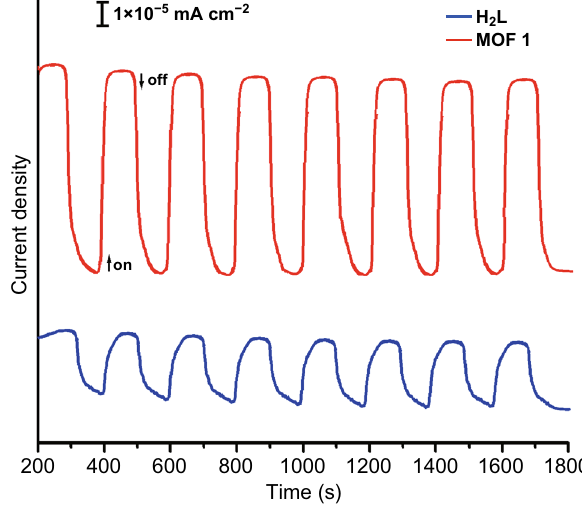
Fig. 3 Comparison of photocurrent time plots of ZnL(DPE) (H 2 O)·H 2 O and free H 2 L ligand. Reprinted with permission from Ref. [15]. Copyright 2016,